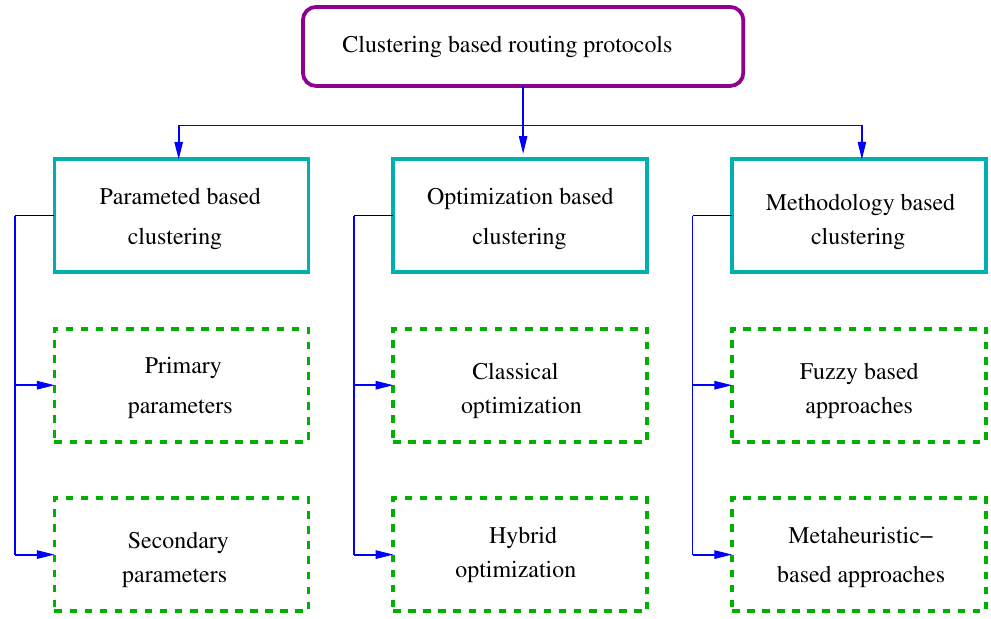
Figure 5. Classification of clustering-based routing protocols reproduced from Manuel et al.